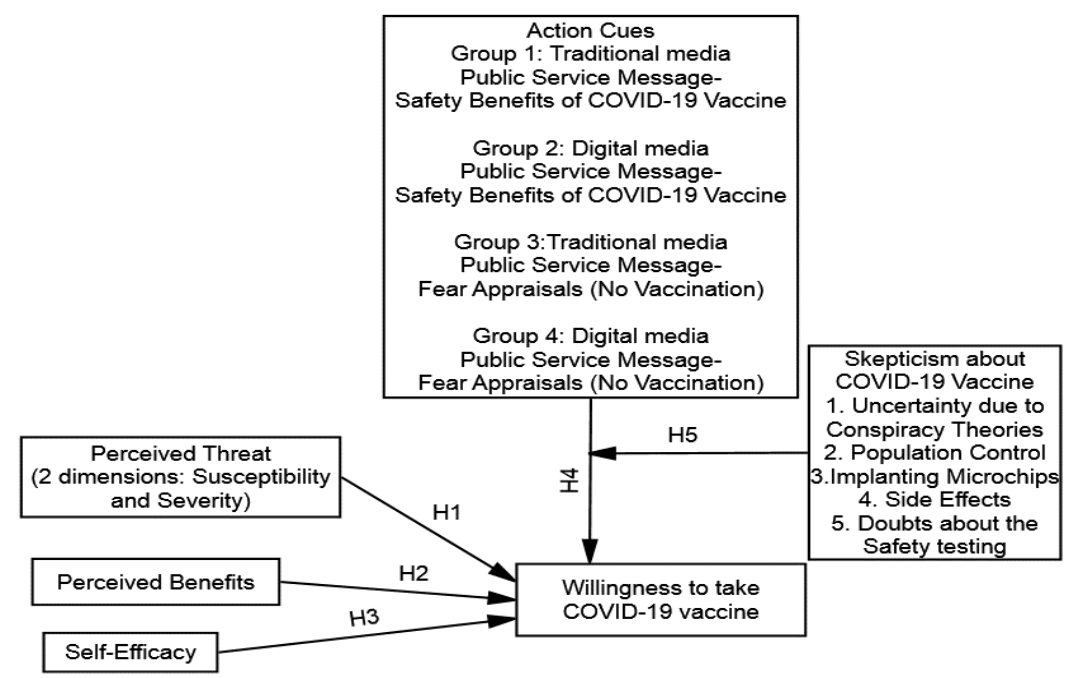
Figure 1. Conceptual Model of Study .